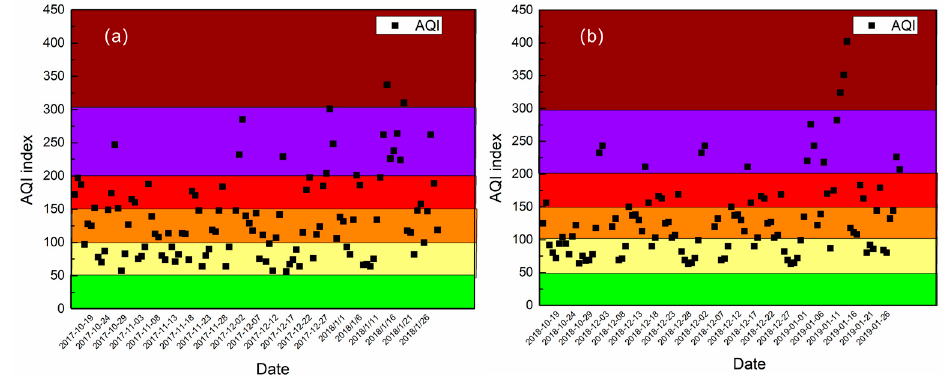
Figure 2. AQI index of autumn–winter seasons of 2017–2018 ( a ) and 2018–2019 ( b ). Water-soluble inorganic ions are important components of PM 2.5 which mainly in- clude NO 3 − , SO 42 − , NH 4+ , K + , Ca 2+ , and Cl − [29,30]. These inorganic ions play an important role in the formation of PM 2.5 . On average, the most abundant water-soluble species in